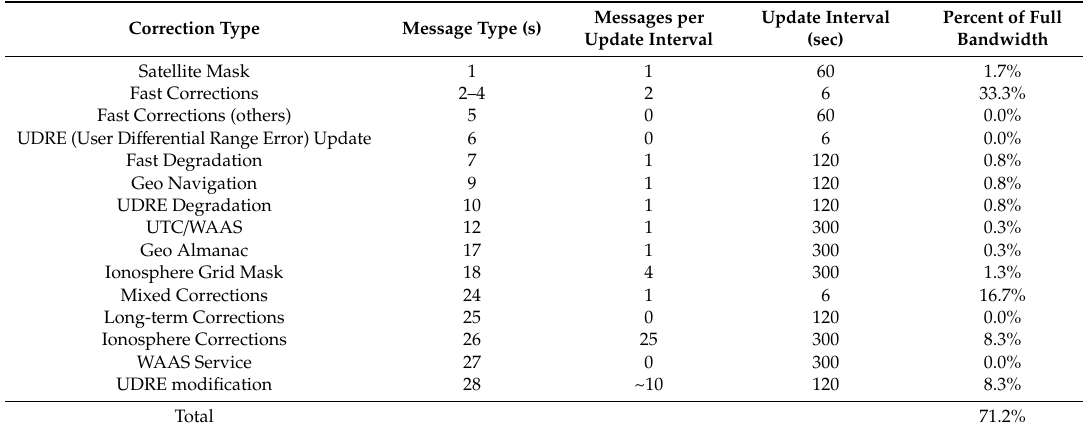
Table 1. Current Wide Area Augmentation System (WAAS) data update interval and usage